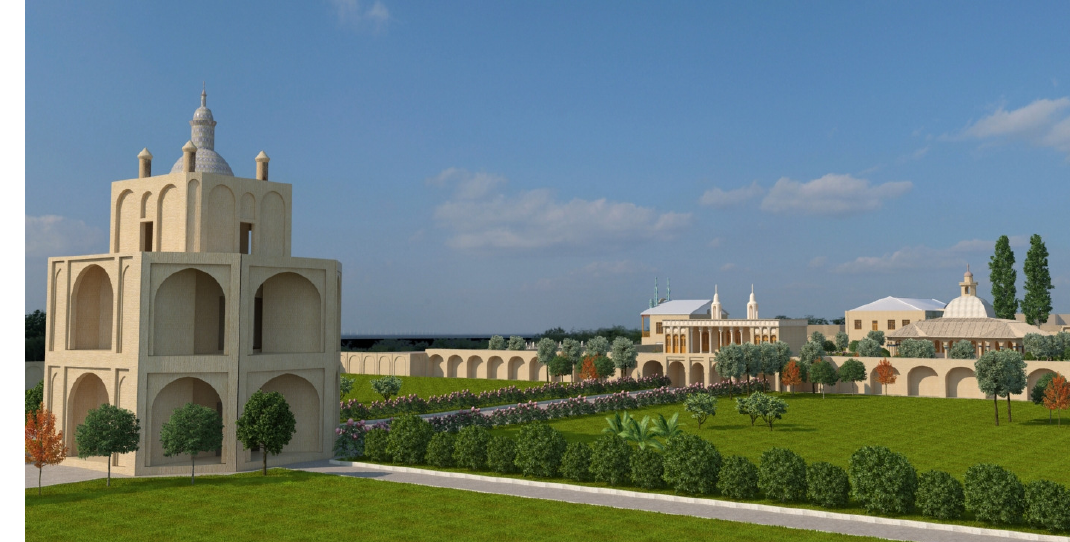
Image 5: 3D image of Mofakham complex in 1892, view to